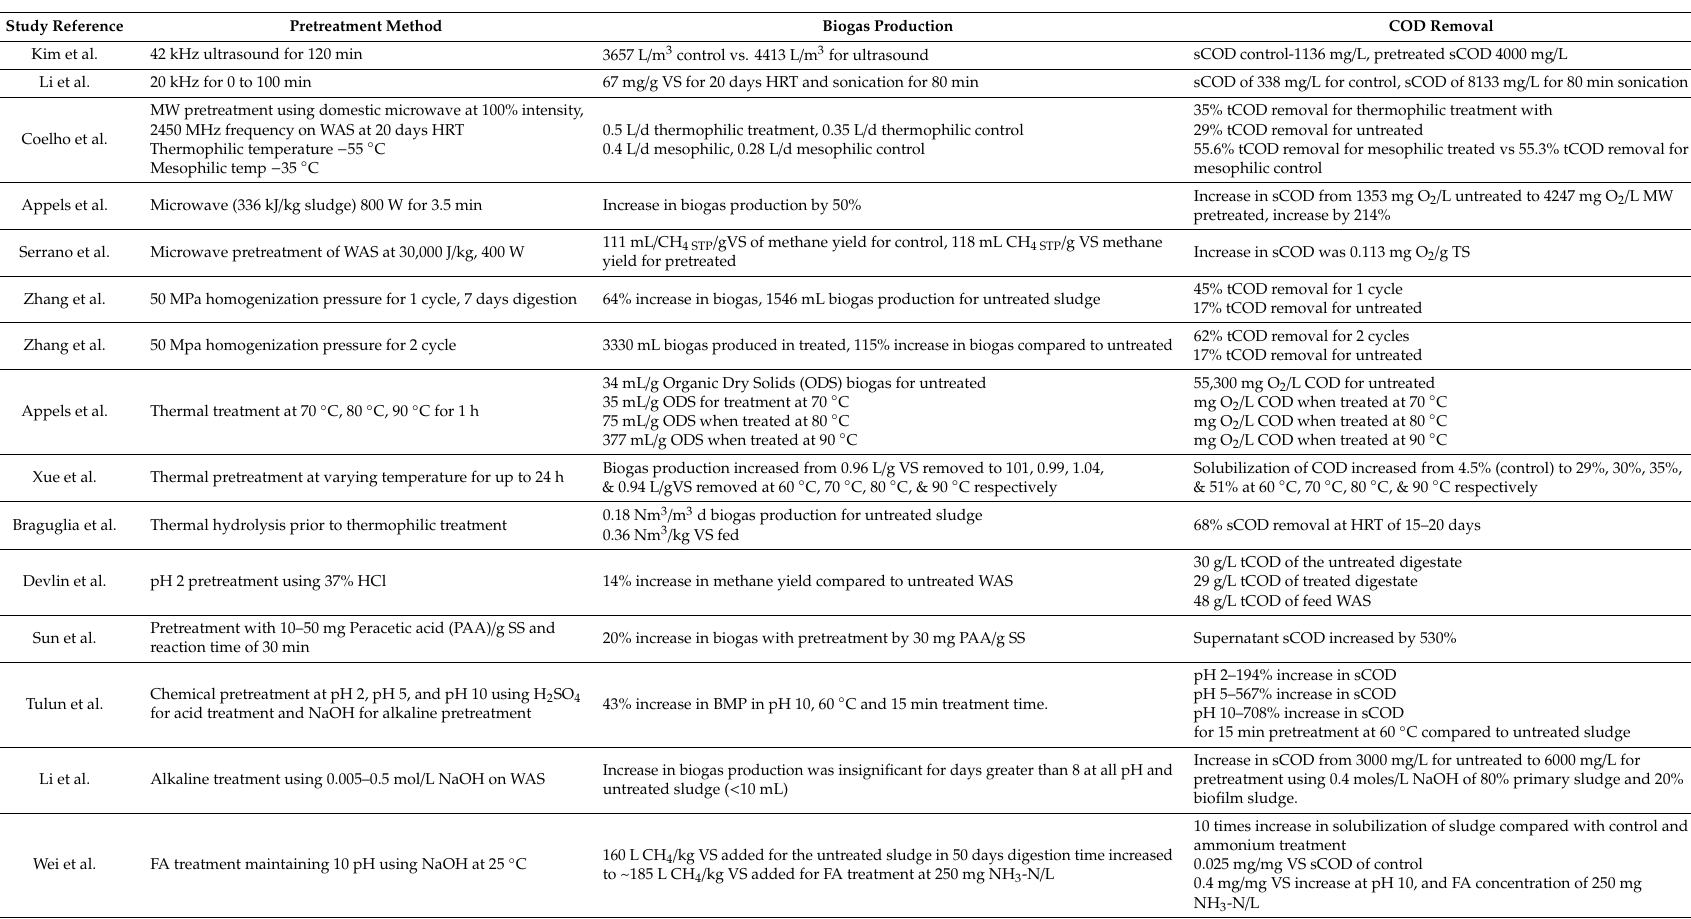
Table 2. Summary table of the biogas production and Chemical Oxygen Demand (COD) removal from di ff erent pretreatment